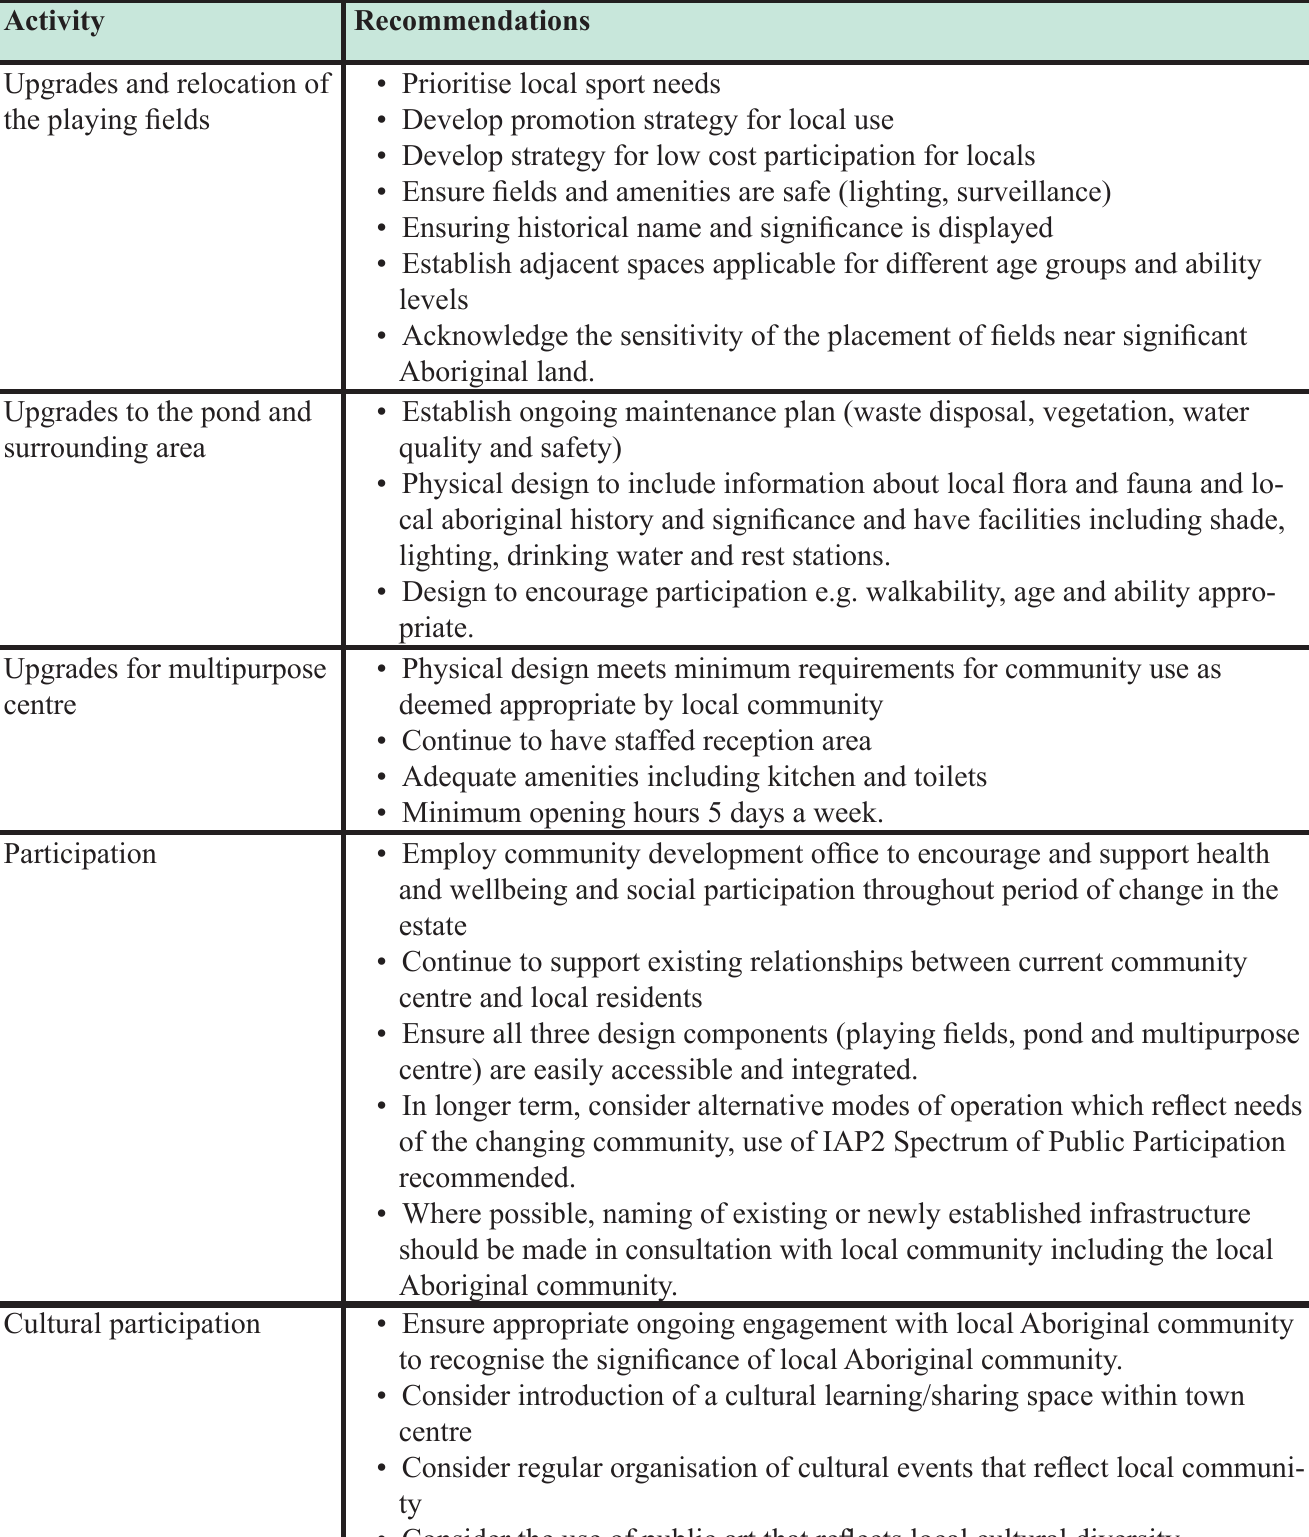
Table 3: Summary of key